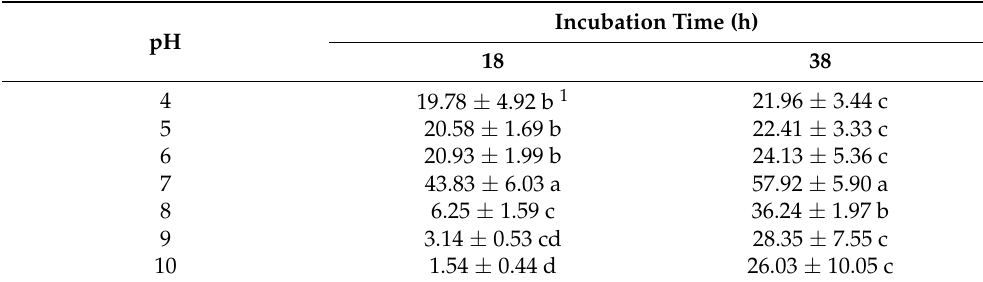
Table 6. Conidial germination rate (%) of Paraphoma radicina at seven pH values at 18 and 38 h. Grown at 25 ◦ C and L:D